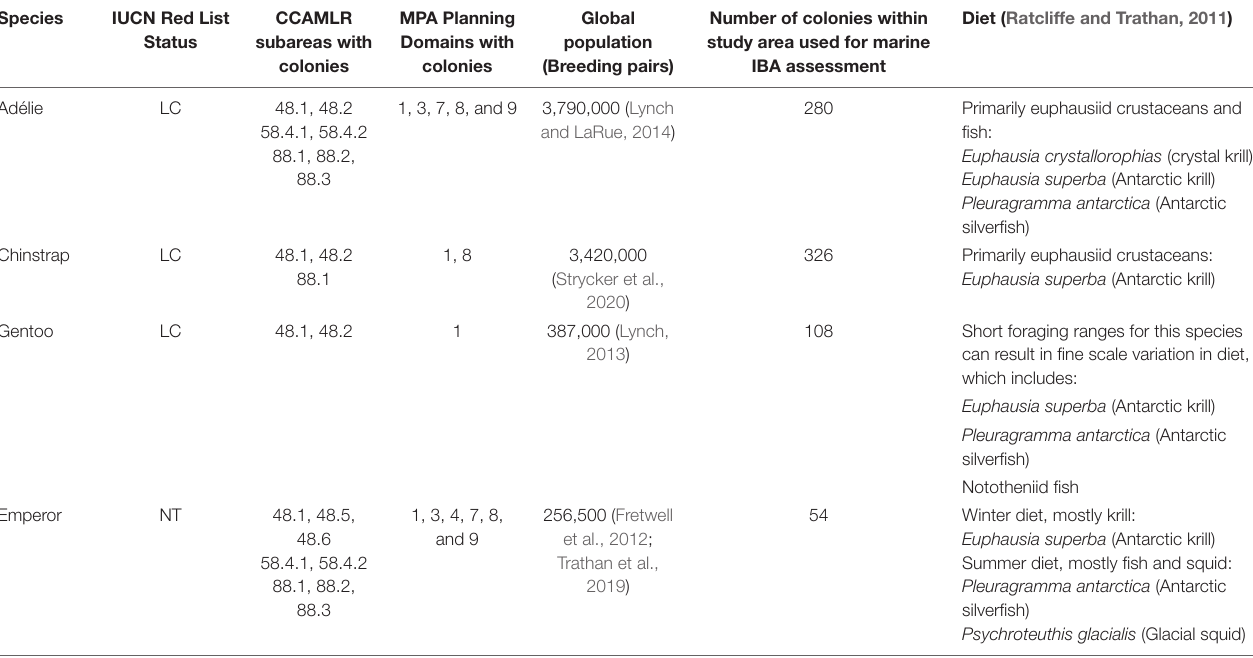
TABLE 1 | Penguin species that breed on mainland Antarctica or adjacent islands, their diet, and key metadata, considered for the identification of marine Important Bird and Biodiversity Areas in Antarctica.